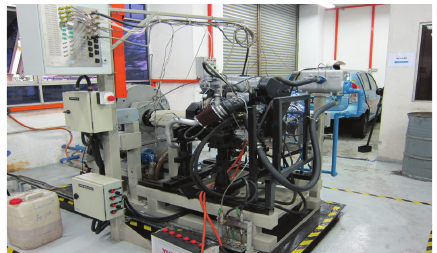
Figure 1: Picture of the engine test bed.